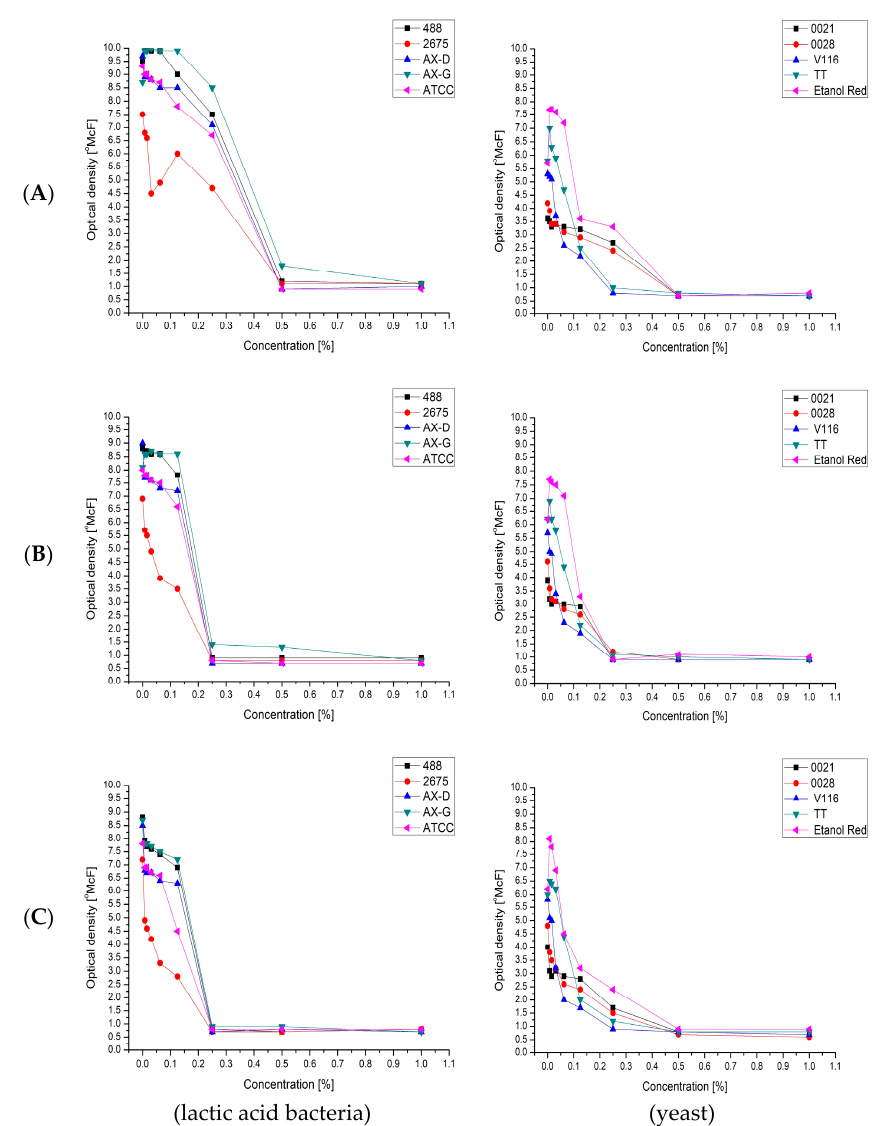
Figure 5. Minimal inhibitory concentration of: furfural ( A ); vanillin ( B ); and levulinic acid ( C ); for selected: lactic acid bacteria and yeast strains.